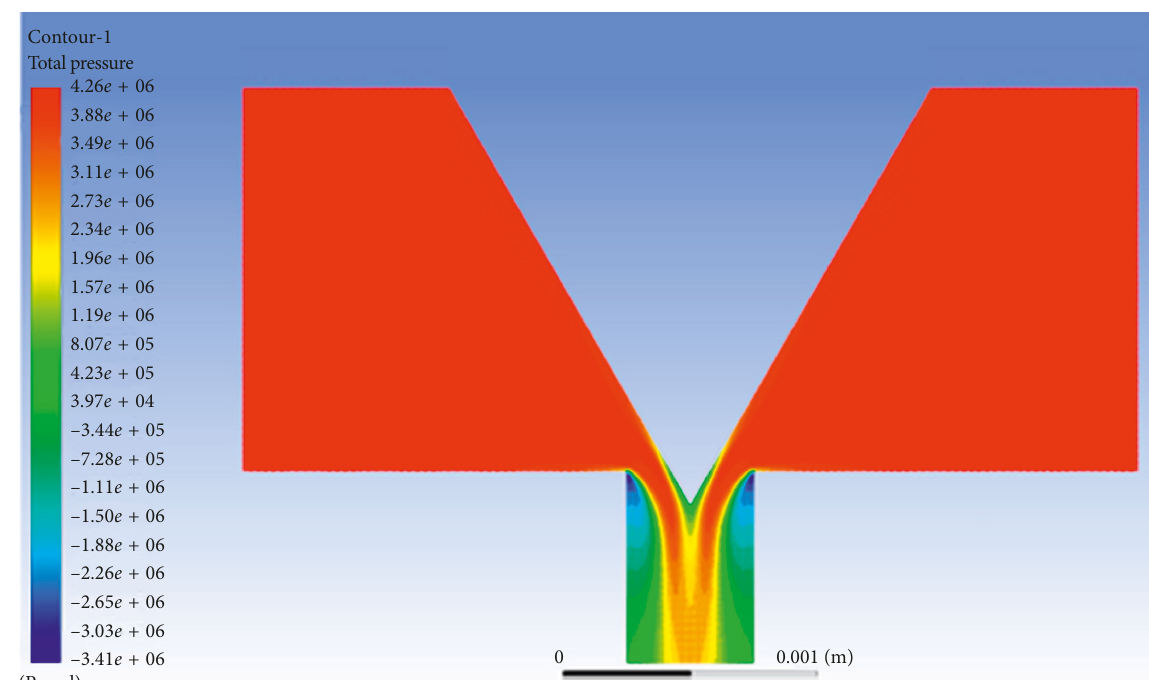
Figure 28: Pressure nephogram of a poppet valve core angle of 60 °